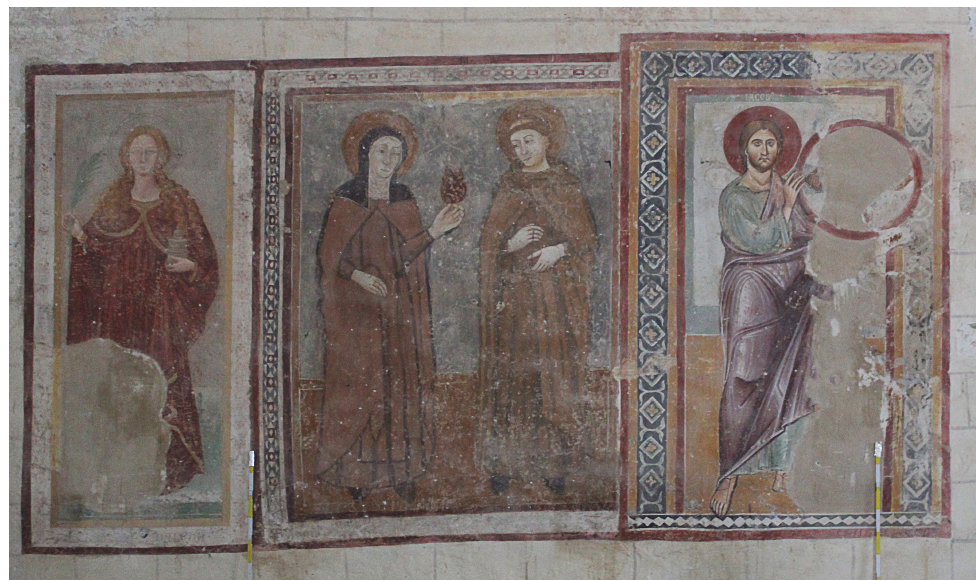
Figure 8. One of the frescoes under investigation, in particular the one composed by an apostle proceeded by three Saints Maddalena, Stefano and Lorenzo. In the pic are visible the reflective meter-sticks located as reference points for the subsequent post-processing (see the cone of vision 4 in Figure